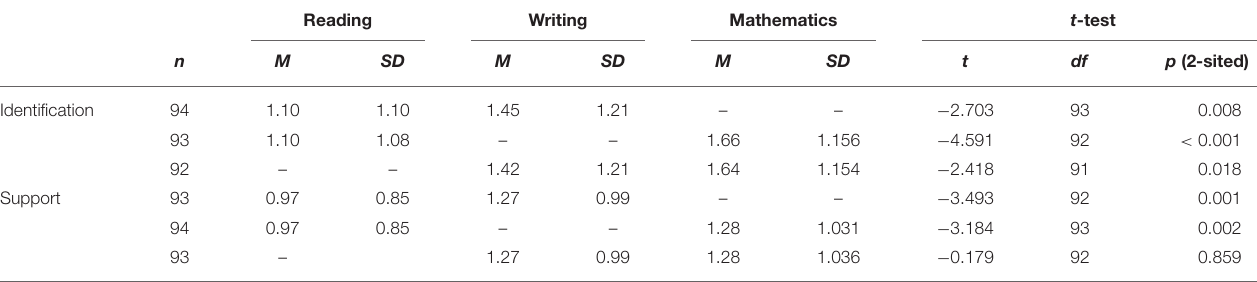
TABLE 6 | Differences between reading, writing, and mathematics regarding identification and support.